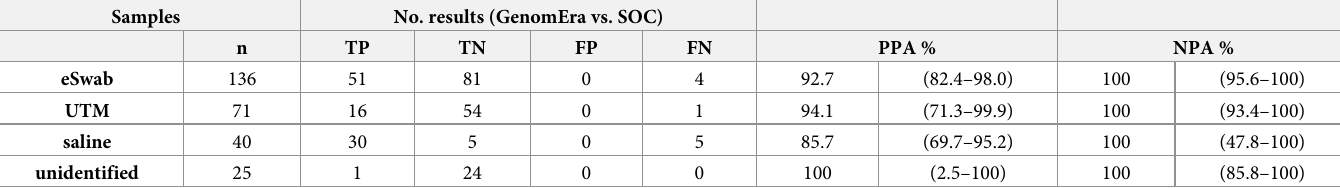
Table 5. Transport media dependent agreement of the GenomEra SARS-CoV-2 test and SOC RT-PCR tests. Samples